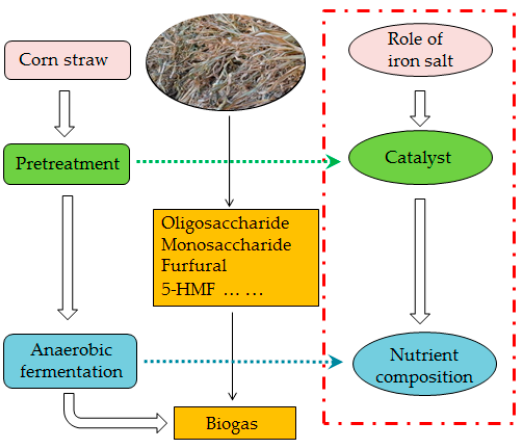
Figure 1. Role of iron salt in the whole process from lignocellulose to biogas.